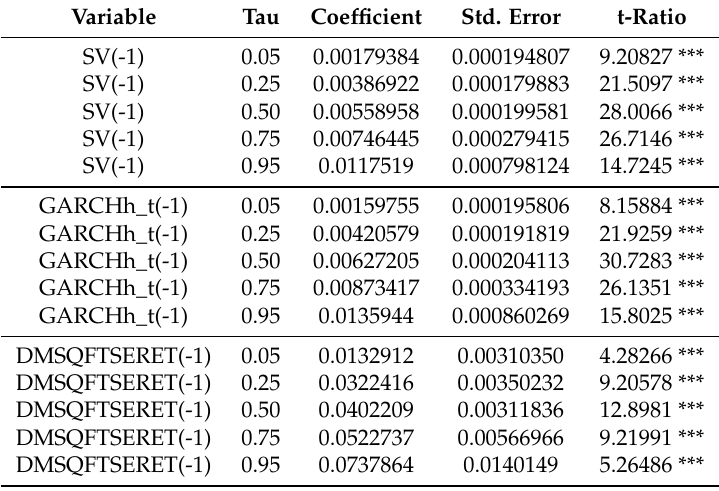
Table 6. Quantile-regression results of SQRV5L regression on lagged SV, lagged GARCH and lagged DMSQFTSERET Quantile estimates, using 27 April 2009–16 April 2019 observations (T = 2454). Asymptotic standard errors assuming independent and identically distributed (IID) errors. Variable